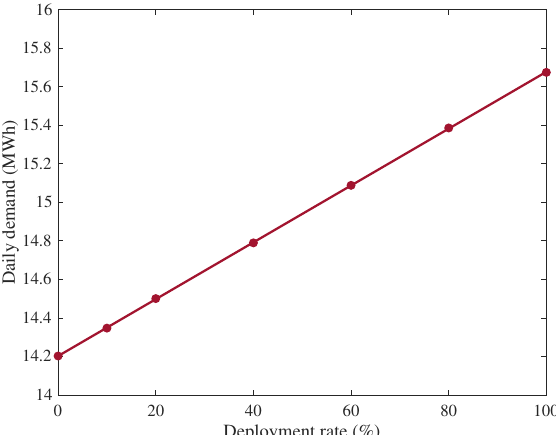
Figure 11. Feeder’s daily demand with different EVs deployment rates.